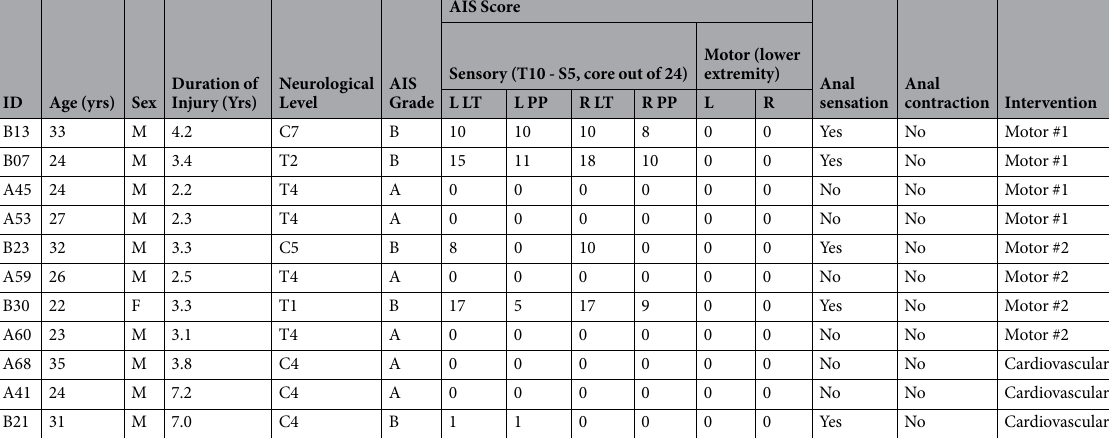
Table 1. Clinical characteristics of the research participants. Sensory score was designated by light-touch (LT) and pinprick (PP) of the left (L) and right (R) lower limb, below the level of injury. Neurological level: neurological level of the lesion; AIS: American Spinal Injury Association (ASIA) Impairment Scale. Each research participant was enrolled in an interventional study focused on either the facilitation of standing and stepping (Motor #1 and Motor #2) or the recovery of cardiovascular function